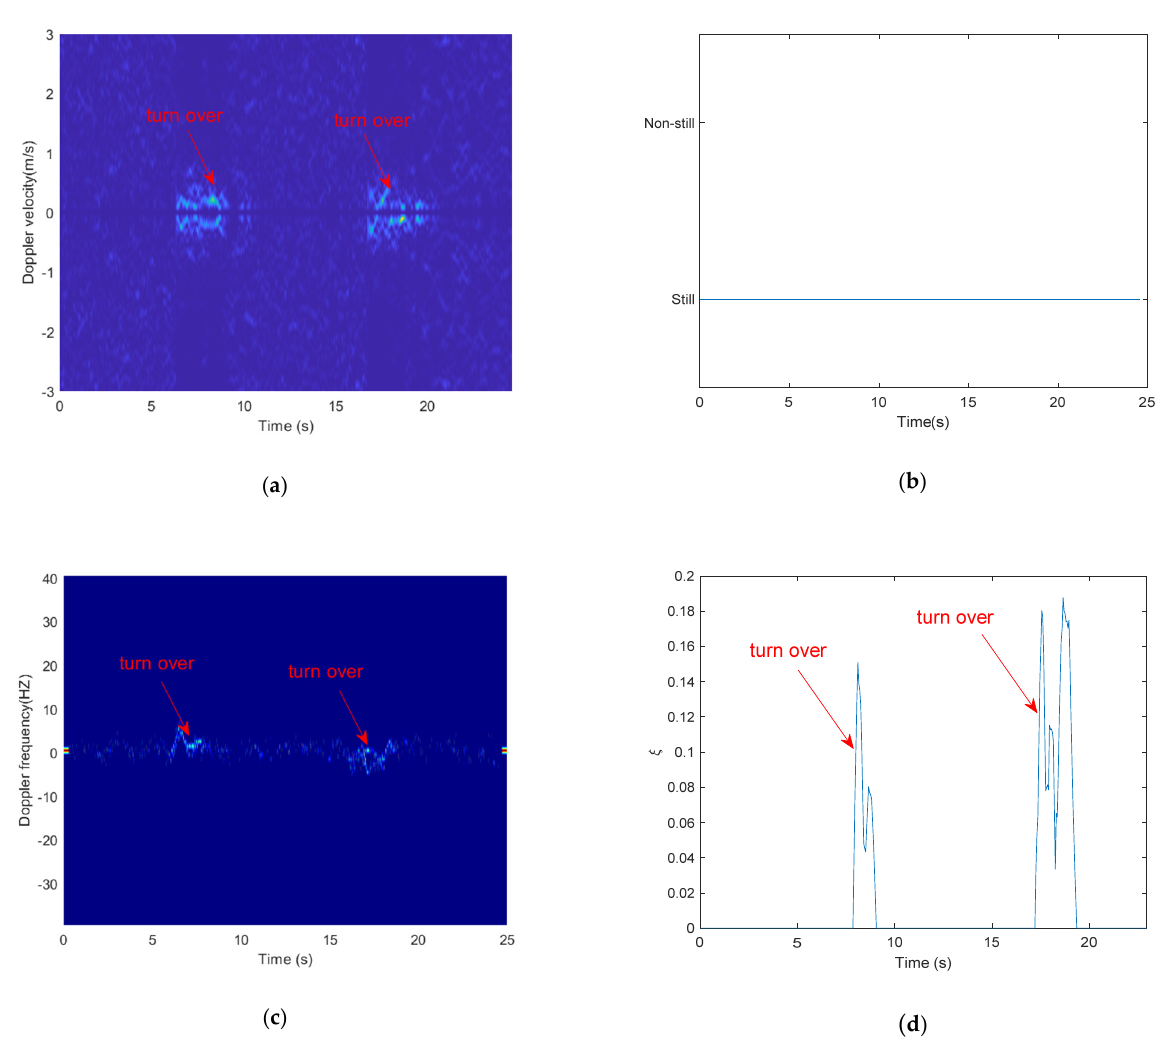
Figure 15. The comparison of Doppler-Music method and our proposed method for detecting turn over on the bed. ( a ) speed-time spectrum obtained from Doppler-Music method; ( b ) motion state obtained from Doppler-Music method; ( c ) Frequency-time spectrum obtained from our proposed method; ( d ) activity intensity obtained from our proposed method.